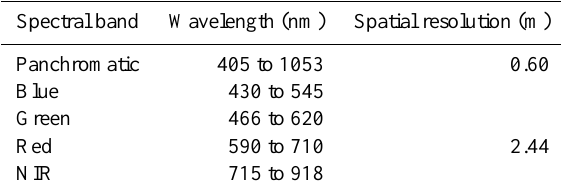
Table 2. Spectral characteristics of QuickBird satellite